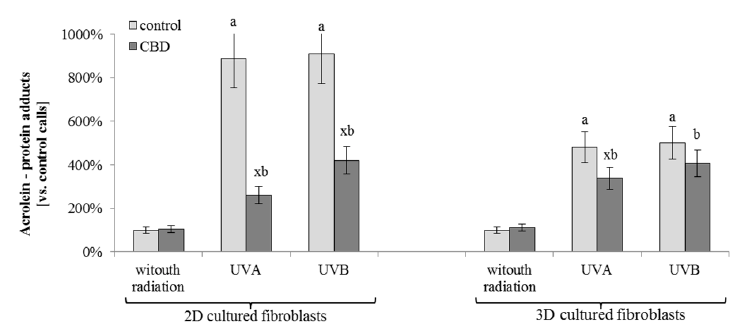
Figure 5. The level of proteins modified by lipid peroxidation products (malondialdehyde (MDA), 4-hydroxynonenal (4-HNE), acrolein) adducts formation in fibroblasts irradiated with UVA (20 J/cm 2 ) and UVB (200 mJ/cm 2 ) or/and treated with cannabidiol (CBD, 4 μ M) in two-dimensional (2D) or three-dimensional (3D) culture model. Mean values ± SD of tree independent experiments are presented. x—statistically significant differences between CBD treated and corresponding non-treated cells, Q < 0.05; a—statistically significant differences vs. control group, Q < 0.05; b—statistically significant differences vs. CBD treated group, Q < 0.05.